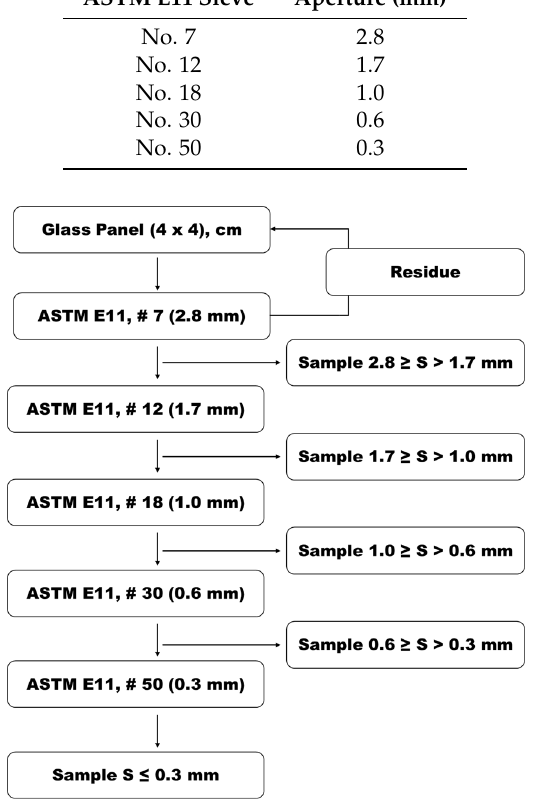
Figure 1. Flowchart for classification of the crushed glass cullet from the waste liquid crystal display panels.